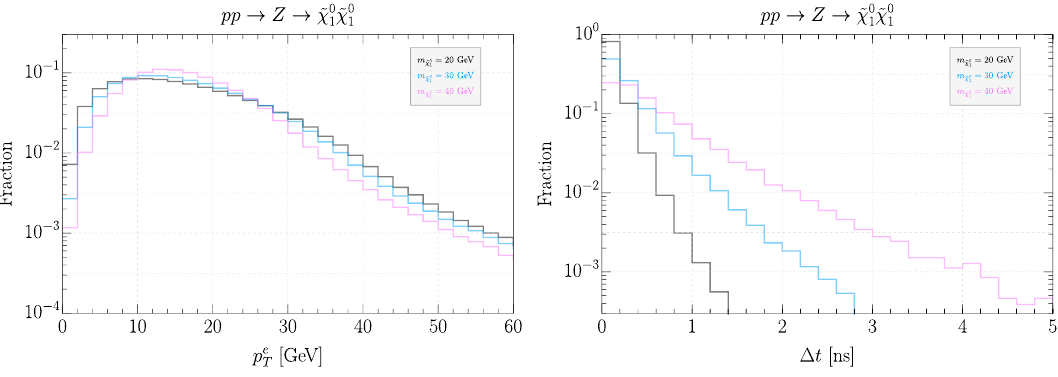
Figure 5 . Distributions of p e